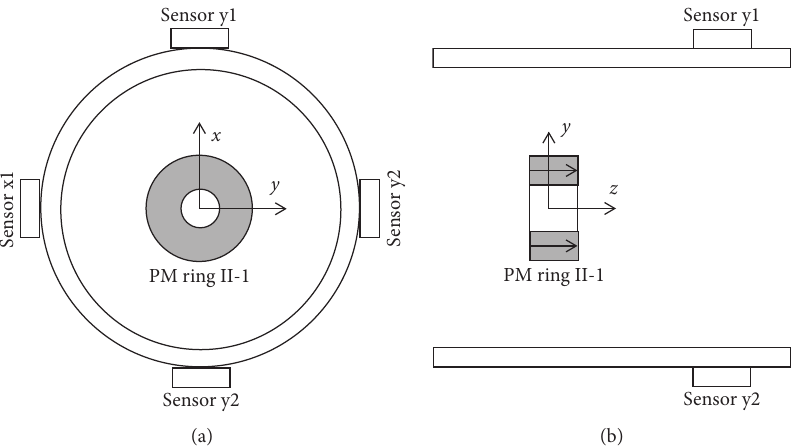
Figure 16: Arrangement of Hall-effect sensors for measurement of axial position: (a) x - y cross section view and (b) y - z cross section view.